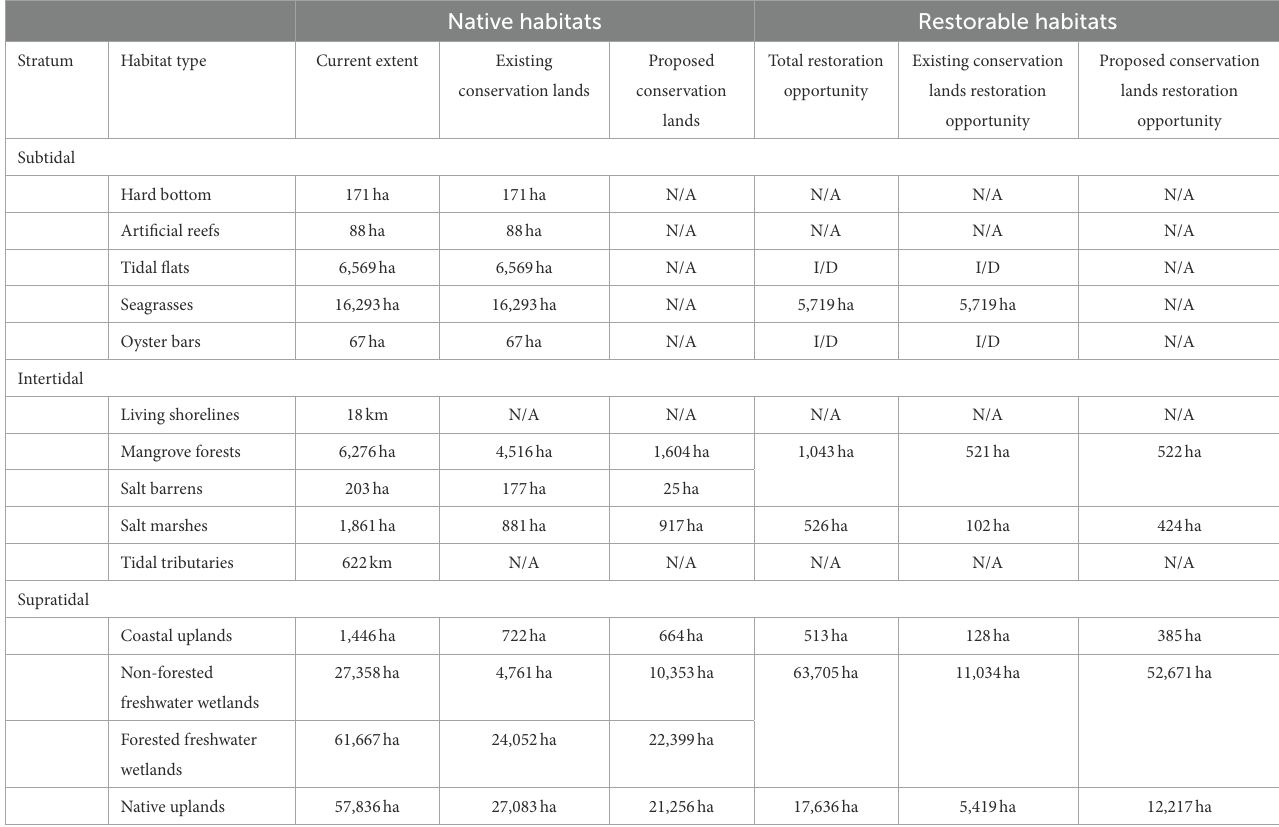
TABLE 4 Summary of habitat restoration opportunities in the Tampa Bay